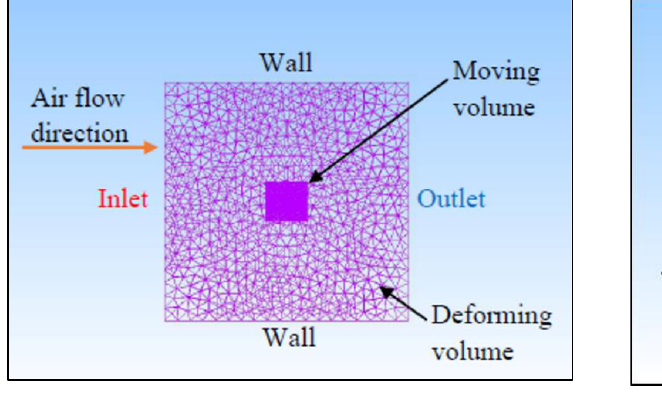
Figure 5. ( a ) Mesh modeling description of the wing for numerical analysis; ( b ) variation of lift co- efficient with time step at various flapping frequencies.